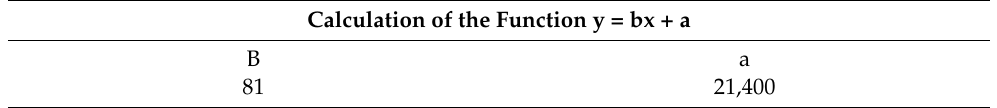
Table 3. Results of expert forecasting in pcs.